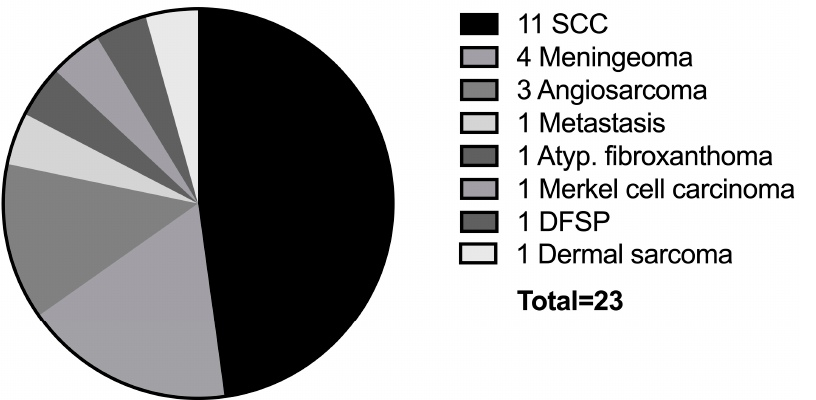
Figure 2. This diagram depicts the oncologic diagnosis in our tumor patients. SCC: Squamous cell carcinoma; Atyp. Fibroxanthoma: atypical fi broxanthoma DFSP: dermato fi brosarcoma protuberans.